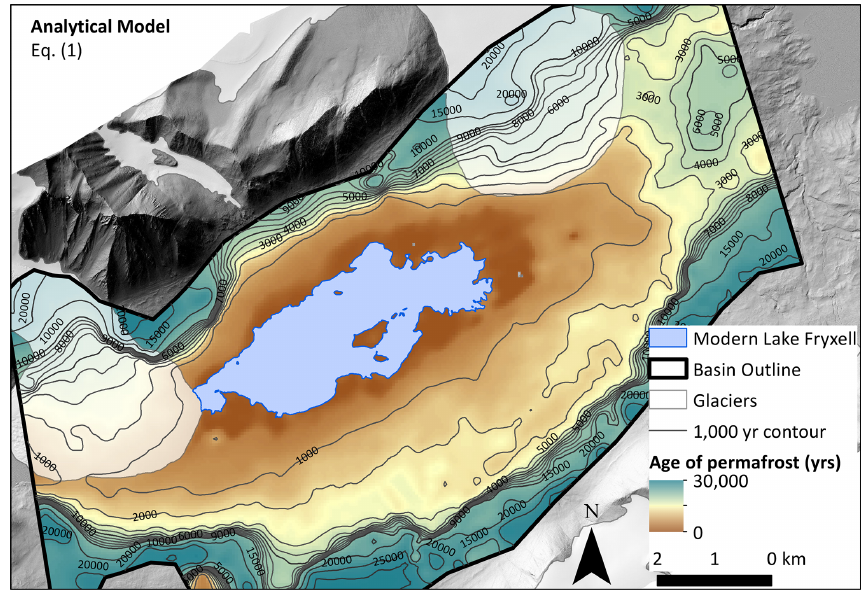
Figure 14. Analytical model results of maximum permafrost age distribution in Fryxell basin calculated using Eq. (1) (Osterkamp and Burn, 2003). Age is calculated using depth to permafrost–brine boundary (defined as 100 (cid:127) m). Contours represent age of permafrost in years before present, implying higher lake levels (up to 81ma.s.l. sill level) during the Late Holocene, ∼ 1 . 5ka. Note that contours switch to 5000- year intervals after 10000 years. Because of such a large permafrost age gradient at high elevations, the 1000-year contours were illegible. The DEM (1m resolution) is from a 2014–15 lidar survey, accessed via OpenTopography (Fountain et al., 2017).